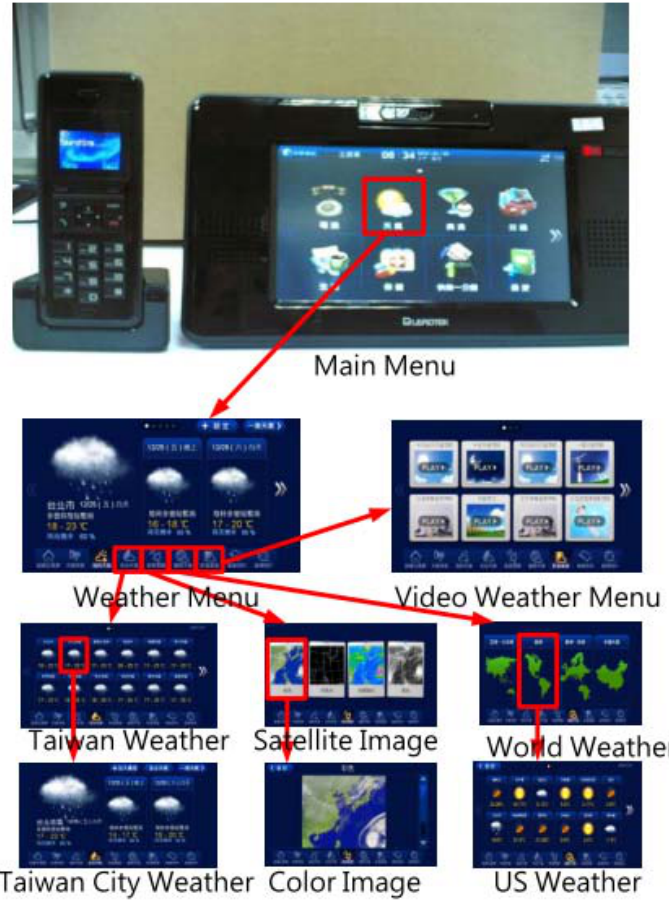
Figure 5. Weather Forecast